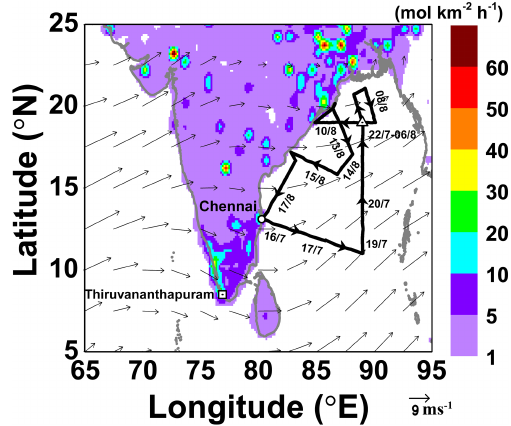
Figure 1. Cruise track (continuous black line) of the Research Ves- sel Sagar Kanya along with synoptic winds at 925hPa (black thin arrows) and NO x emissions in background colour map. The dates corresponding to approximate ship positions are marked along the track. The start and end position of the cruise, stationary position of the ship, and Thiruvananthapuram are shown by the circle, triangle and square,